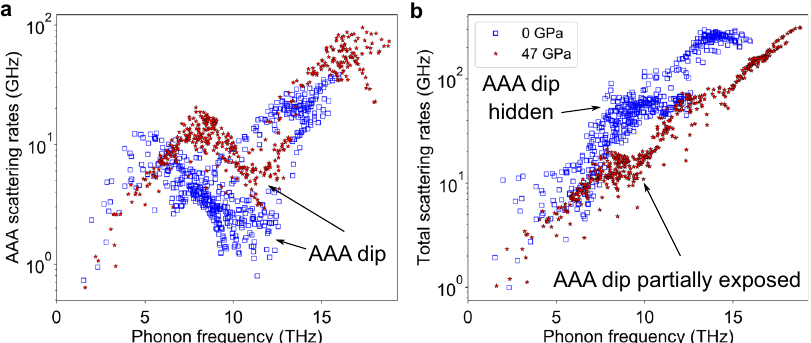
Fig. 4 AAA and total three-phonon scattering rates for BP at different pressures. a AAA scattering rates and b total three-phonon scattering rates for 11 BP at P = 0 GPa and P = 47 GPa at 300 K.